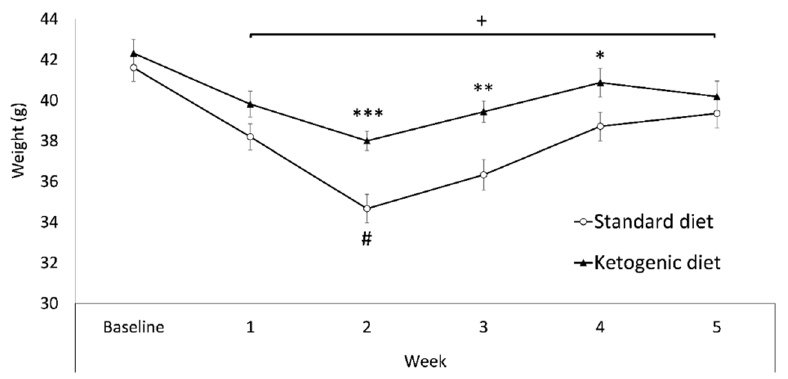
Figure 3. Weekly bodyweight. Data are represented as the mean (±SEM) bodyweight measured weekly. *** p < 0.001; ** p < 0.01; * p < 0.05 significant difference with respect to the SD group. + p < 0.05 significant difference with respect to the baseline. # p < 0.001 significant difference with respect to the rest of the weeks.